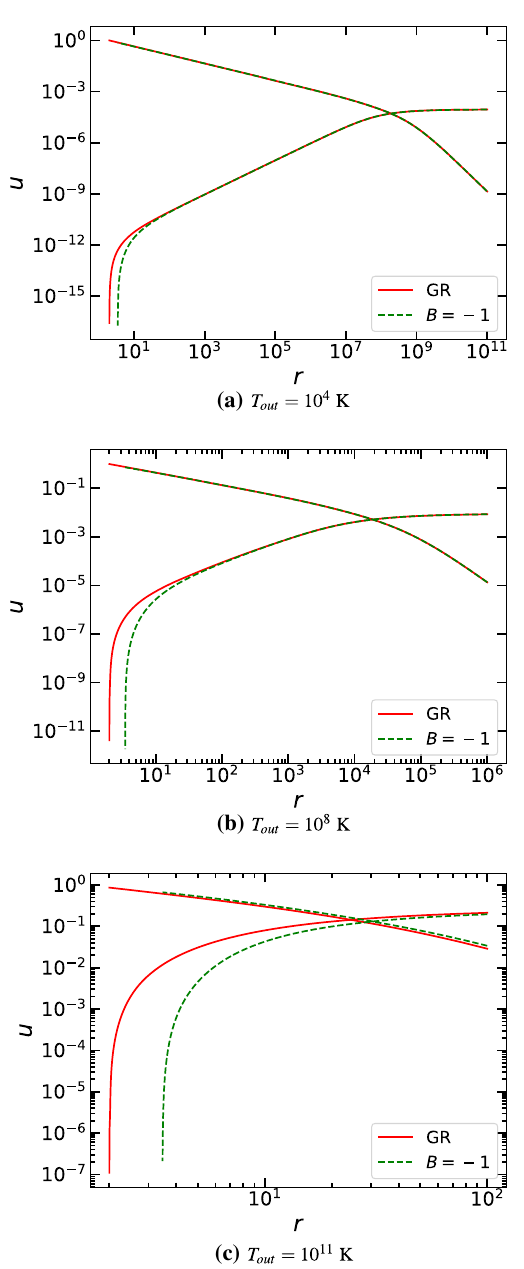
Fig. 5 Spherical accretion flow in modified gravity: red solid line cor- responds to the Schwarzschild spacetime and green dashed line corre- sponds to the f ( R ) gravity with B = − 1. The top panel is obtained considering outside temperature 10 4 K, middle panel is for 10 8 K and thebottom panel corresponds to10 11 K. Allthe quantitiesare expressed in dimensionless unit with c = G = M = 1 T out is very small. However, since the event horizon shifts in the case of the modified gravity, both the accretion and wind branchesaredeviatedfromthoseinthecaseofSchwarzschild spacetime, close to the central object, particularly visible for higher T out . At r = r H , the velocity of accreting particle reaches the velocity of the light, whereas the wind